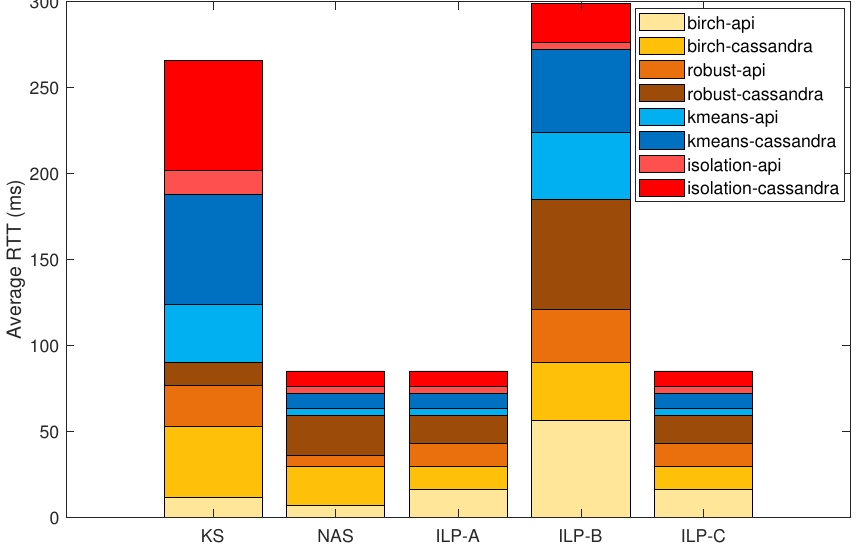
Figure 12. Comparison of the average RTT per scheduler for different pod-deployment scheduling strategies in a Smart City air quality monitoring